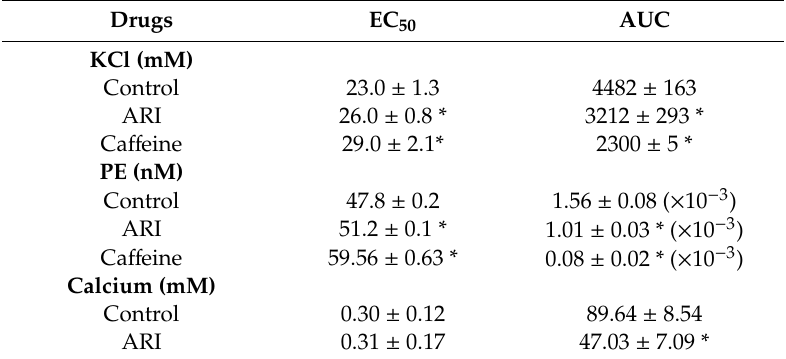
EC 50 represents the half maximal effective concentration. The values are mean ± S.E.M. represents the mean of at 6 independent experiments. Statistically significant difference * p < 0.05 vs. Control.